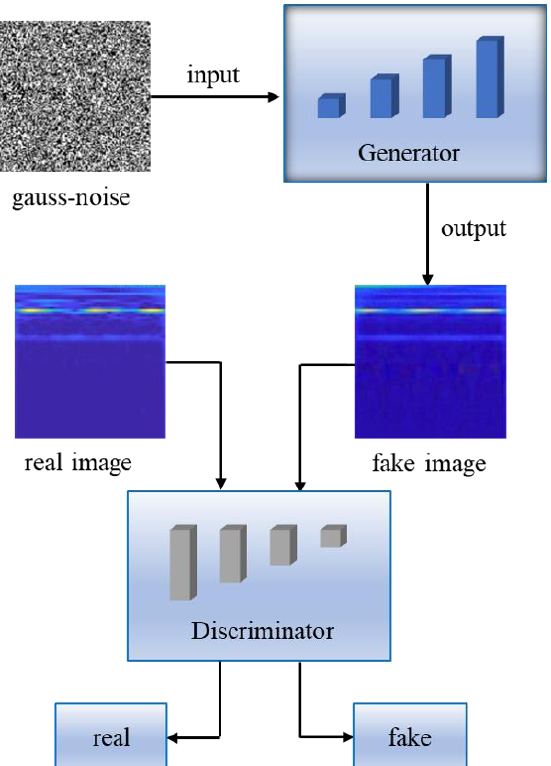
Figure 3. WGAN-GP structure diagram.